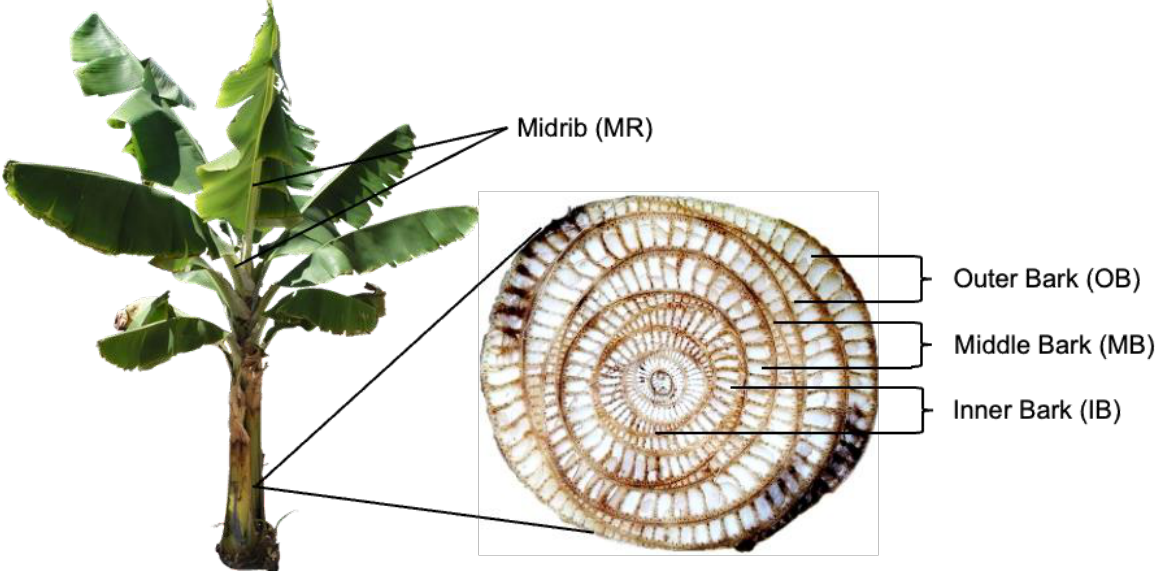
Figure 1. Banana tree and cross-section of banana stem.